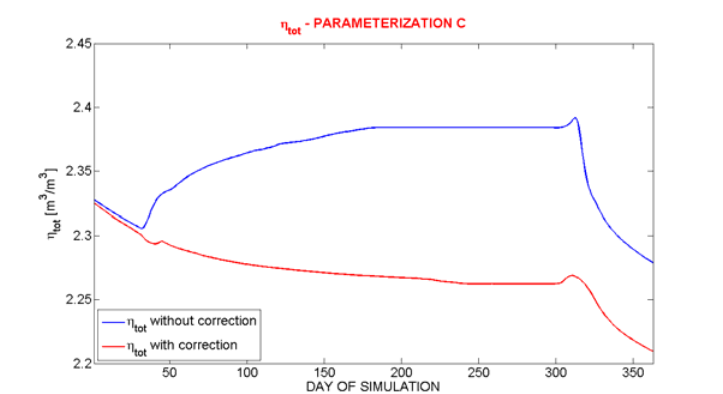
Figure 16. Same as Figure 14 but for the parameterization